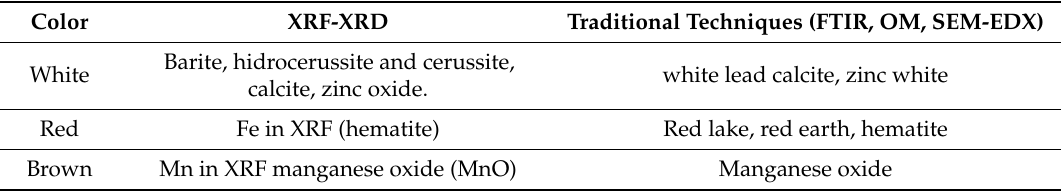
Table 3. Main color composition detected by XRF-XRD prototype and comparison with traditional techniques (OM, FTIR and SEM-EDX). Color XRF-XRD Traditional Techniques (FTIR, OM, SEM-EDX) Barite, hidrocerussite and cerussite, White white lead calcite, zinc white calcite, zinc oxide. Red Fe in XRF (hematite) Red lake, red earth, hematite Brown Mn in XRF manganese oxide (MnO) Manganese oxide NOTE: White lead or hydrocerussite (2PbCO 3 · Pb(OH) 2 ), calcite (CaCO 3 ), zinc white or zinc oxide (ZnO), barite